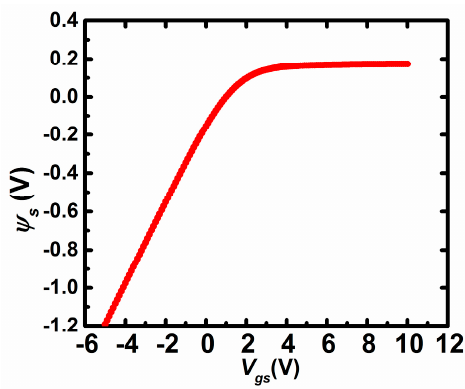
Figure 3. Ψ s versus V gs obtained by (14) based on the capacitance–voltage (C–V)